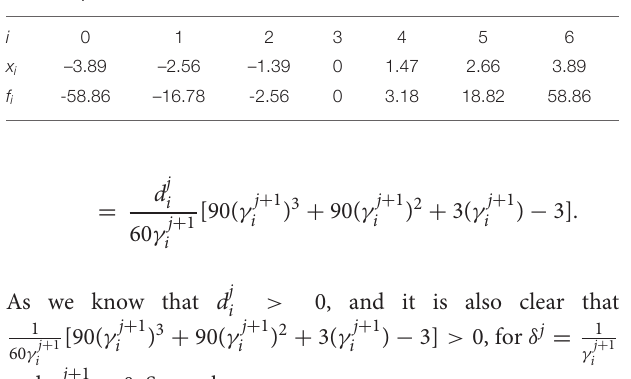
TABLE 6 | Monotonic